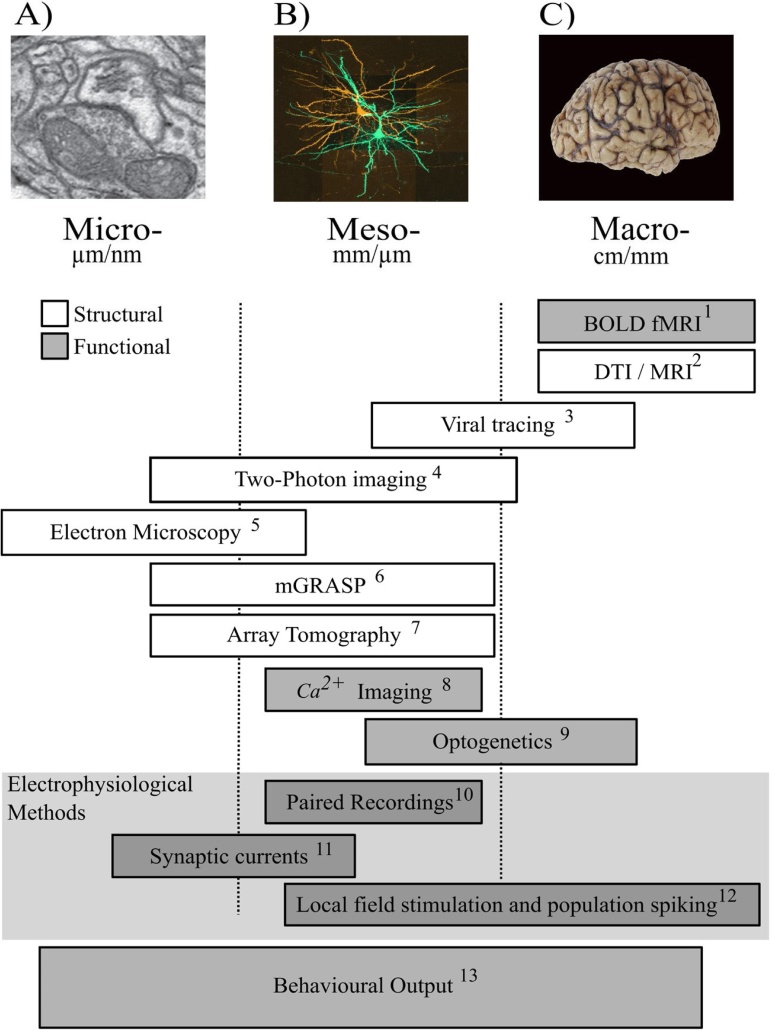
Investigating the connectome.Examples of techniques used to investigate the connectome at different scales. (A) Micro-connectome: electron microscope section through an asymmetric, presumably excitatory synapse (Cheetham et al., 2014). (B) Meso-connectome: Z-stack reconstruction of synaptically-connected pyramidal neurons imaged with confocal microscopy (Cheetham et al., 2007). (C) Human post-mortem brain. (1) Functional connectivity is inferred from brain regions exhibiting temporally-correlated fluctuations in blood-oxygen-level-dependent (BOLD) functional MRI signal (Biswal et al., 1995). (2) White matter tracts can be studied with diffusion tensor imaging (DTI) tractography (Basser et al., 2000). (3) Tracing methods based on molecular tracers or viruses encoding a fluorophore show the long-range axonal projections between brain regions. These tracing studies do not identify both the presynaptic and postsynaptic neurons that form each connection. Transsynaptic tracing technologies have been developed to achieve this e.g. by modifying viruses, such as the rabies virus (DeNardo et al., 2015; Miyamichi et al., 2011; Wickersham et al., 2007; Zingg et al., 2017, 2014). More recently, viral vectors used for tracing have been engineered to encode a fluorophore for tracing and a second protein, such as the calcium indicator GCaMP6s. This facilitates study of the structure of neurons whose activity has been studied in vivo (Wertz et al., 2015). (4) High-resolution two-photon imaging of neurons filled with a fluorophore has been used to follow structural changes in dendritic spines and axonal boutons during learning and experience-dependent plasticity (Holtmaat and Svoboda, 2009). (5) The gold standard for the structural study of synapses is electron microscopy (EM) (Bock et al., 2011; Knott et al., 2002). Focused Ion Beam scanning electron microscopy (FIBSEM) gives serial-section EM images through tissue several micrometres thick (Helmstaedter et al., 2013; Knott et al., 2011). (6) mGRASP (mammalian green fluorescent protein (GFP) reconstitution across synaptic partners) combines tracing with the identification of pre-synaptic and post-synaptic structures. It has been used to study excitatory inputs from CA3 onto CA1 pyramidal neurons in the hippocampus (Druckmann et al., 2014). (7) Array tomography combines ultrathin sectioning with fluorescent labelling of synaptic proteins (Micheva and Smith, 2007). It has been proposed that combining mGRASP with array tomography would facilitate investigation of the meso-connectome with synaptic level resolution (Rah et al., 2015). (8) Calcium imaging uses a calcium-sensitive fluorophore inside the neuron to report when the neuron fires an action potential e.g. (Margolis et al., 2012). (9) Optogenetics can be combined with a variety of techniques to investigate functional circuitry at all three scales of the connectome (Kim et al., 2017). (10–12) Electrophysiological methods are used to investigate the neural activity in the macro-, meso- and micro-connectome. (13) Changes in neural activity within the macro-, meso- or micro-connectome scale circuit may have consequences for behaviour.